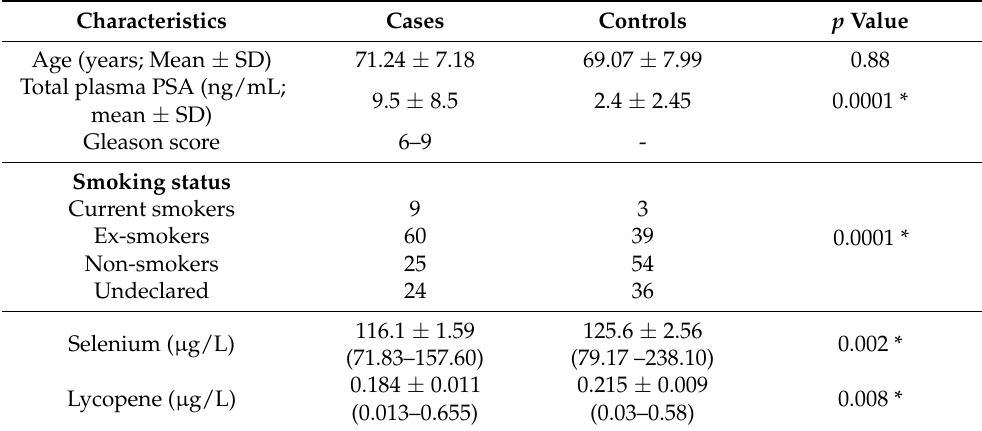
Table 1. Comparison of prostate cases and controls by selected demographic, micronutrient and clinical